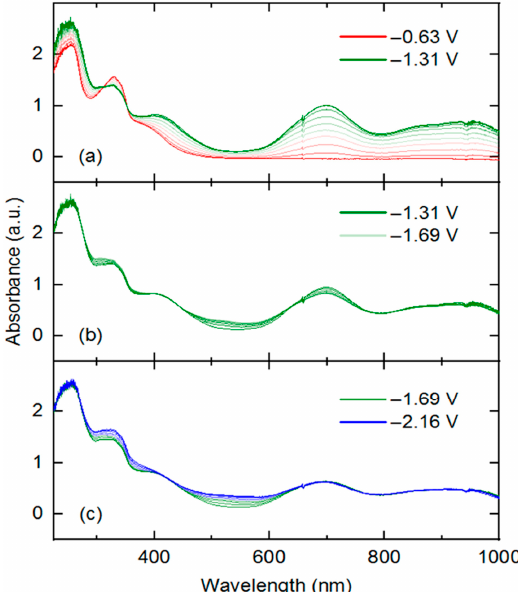
Figure 5. Ultraviolet (UV)-visible-near infrared (NIR) absorption spectra obtained during spectroelectrochemical studies as described in the main text. Initial potentials for each experiment were − 0.63 V (panel a ), − 1.31 V (panel b ), and − 1.69 V (panel c ). Final potentials were − 1.31 V (panel a ), − 1.69 V (panel b ), and − 2.16 V (panel c ). Final potential was held until no spectral changes were reached, indicating full conversion of the thin-layer region to the desired form of the complex. To confirm the apparent chemical reversibility observed in cyclic voltammetry for transformation of 3 to 4 (Figure 2) and 4 to 3 (see SI, Figure S16), an experiment was also carried out with an initial potential of − 1.31 V and final potential of − 0.63 V in an electrolyte solution prepared with 4 (see SI, Figure S26). In this experiment, the evolution of the spectral features detected in the